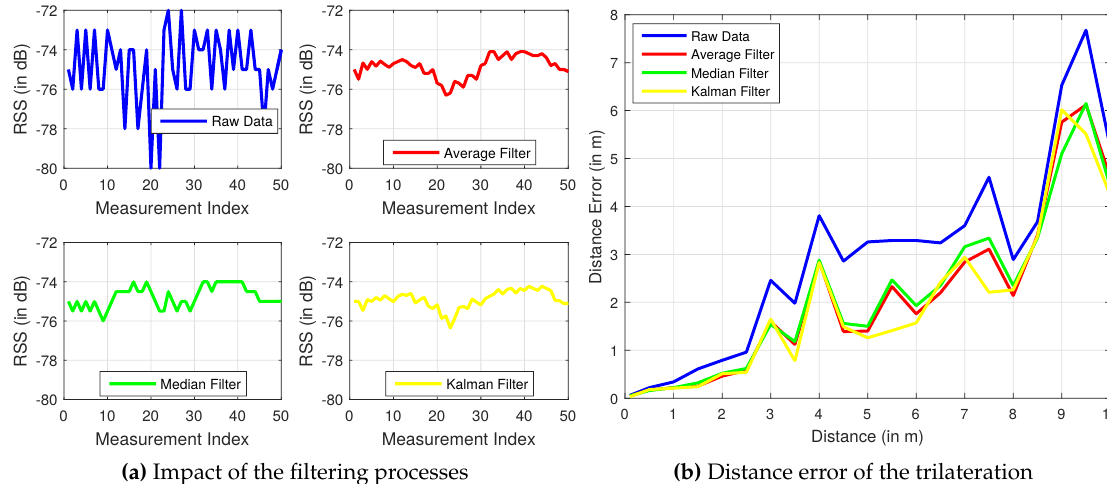
Figure 4. Comparative analysis of the adopted